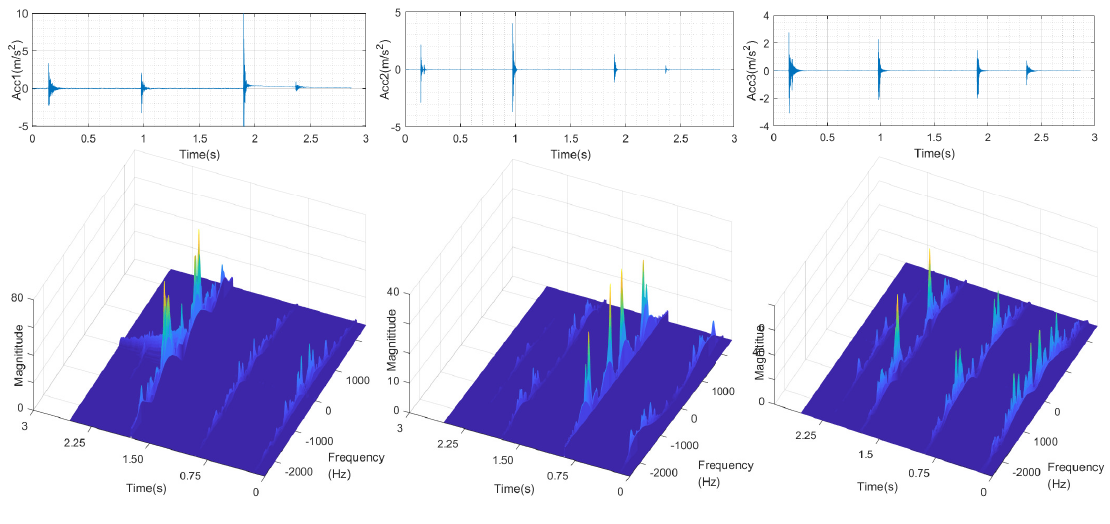
Figure 3. Vibration modes in